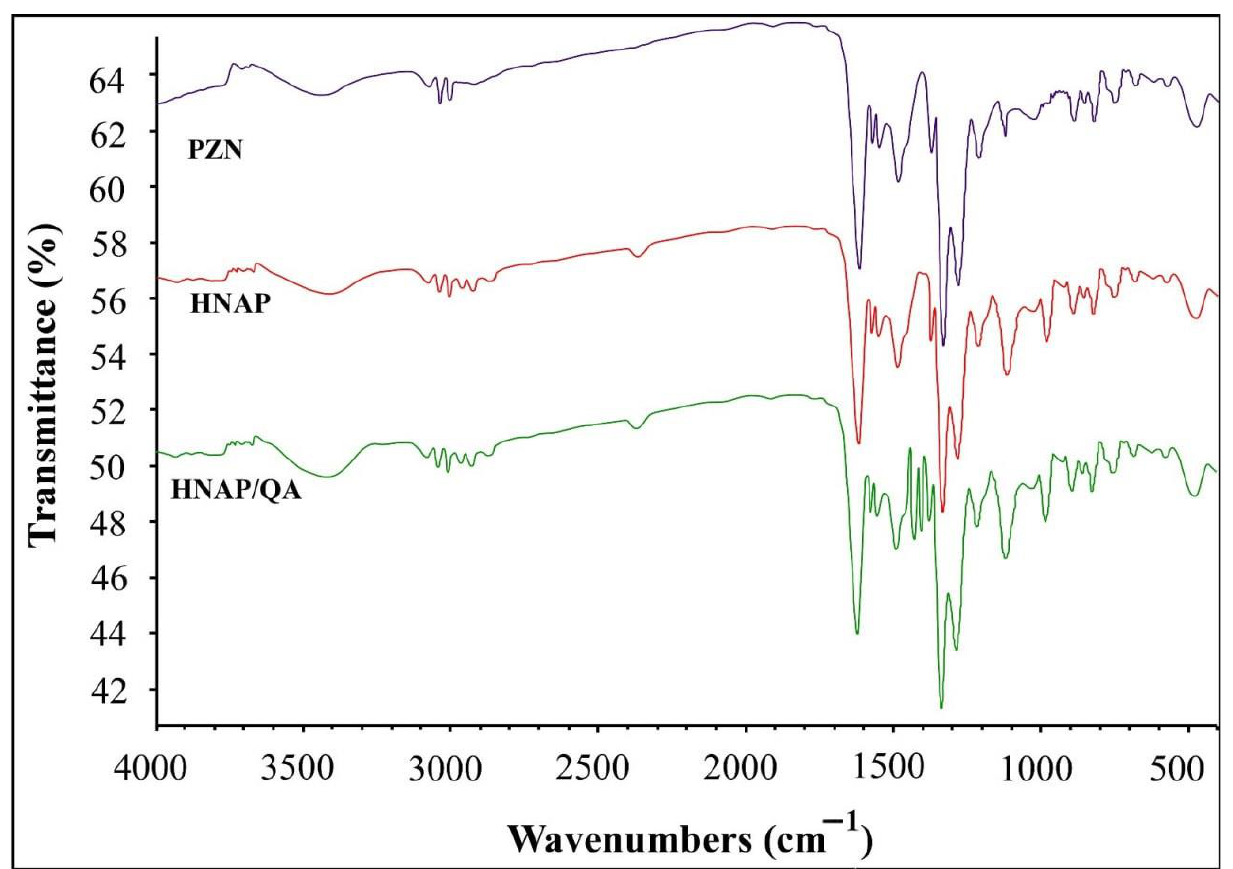
Figure 1. FTIR spectra of PZN, HNAP, and HNAP/QA.